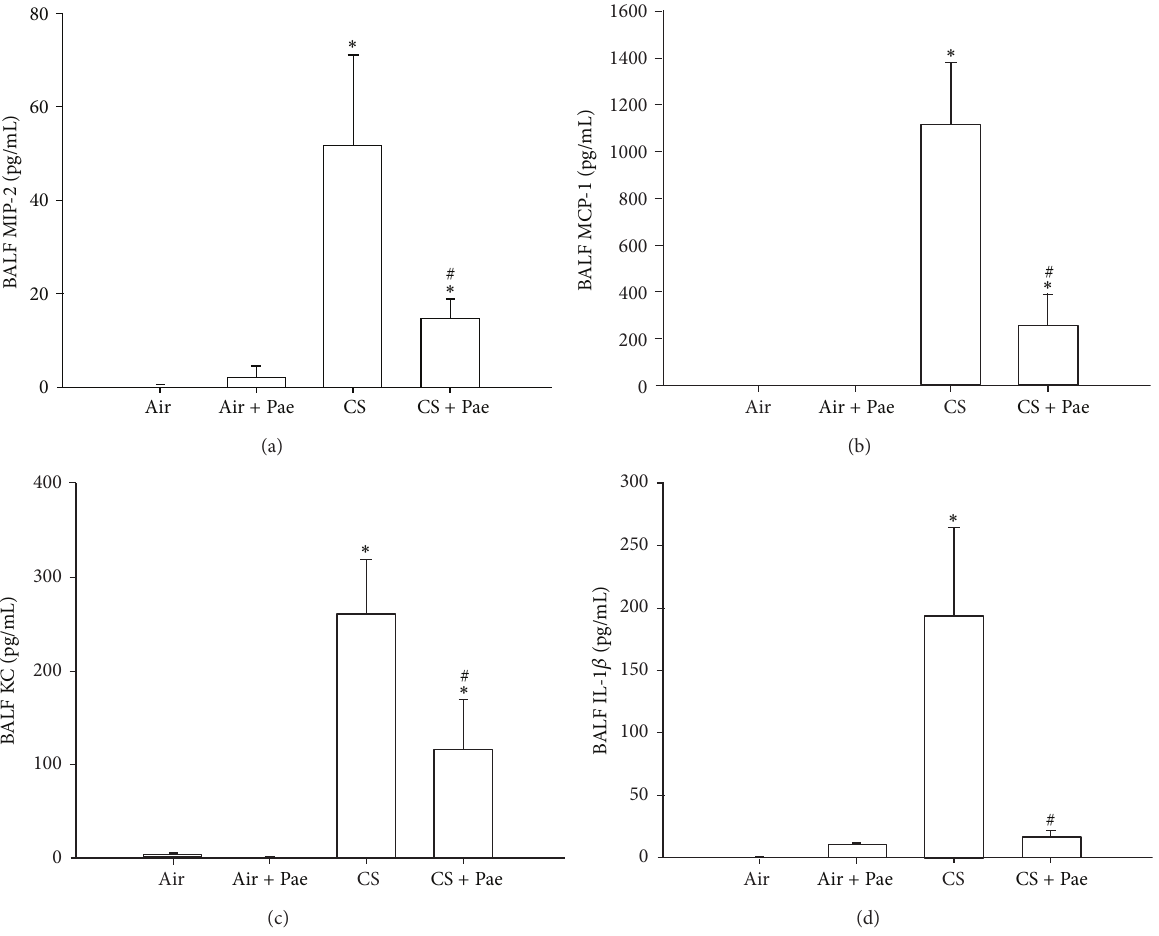
Figure 2: Paeonol (Pae) suppresses cigarette smoke- (CS-) induced increases in proinflammatory chemokines and cytokines in bronchoalve- olar lavage fluid (BALF) sampled from mice. Levels of macrophage inflammatory protein 2 (MIP-2; (a)), monocyte chemoattractant protein-1 (MCP-1; (b)), keratinocyte chemoattractant (KC; (c)), and interleukin-1 𝛽 (IL-1 𝛽 ; (d)) in BALF were analyzed by ELISA. Data in each group are mean ± SEM from 7 mice. ∗ 𝑃 < 0.05 versus the air-exposure group; # 𝑃 < 0.05 versus the CS-exposure group with vehicle treatment. See legend of Figure 1 for detailed information on each study